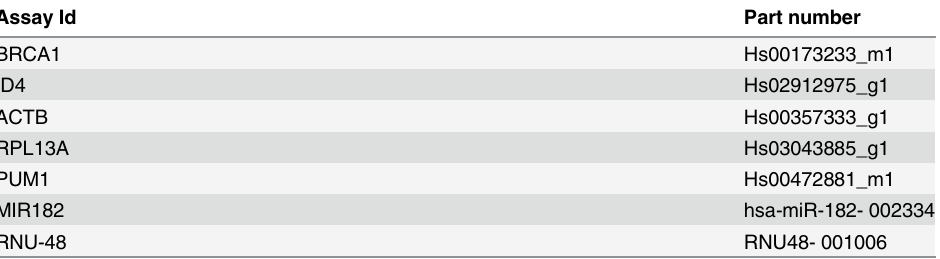
Table 1. Assay part numbers (Gene expression and MicroRNA